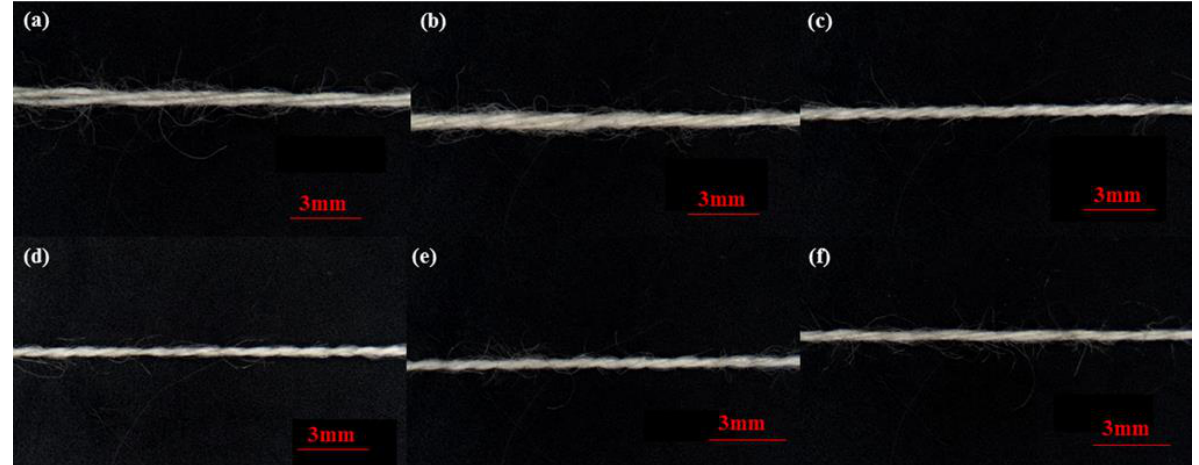
Figure 3. Three-plied zinc yarns: ( a ) 3Zn-0C, ( b ) 3Zn-1C, ( c ) 3Zn-2C, ( d ) 3Zn-3 € ( e ) 3Zn-4C, and ( f ) 3Zn-5C.